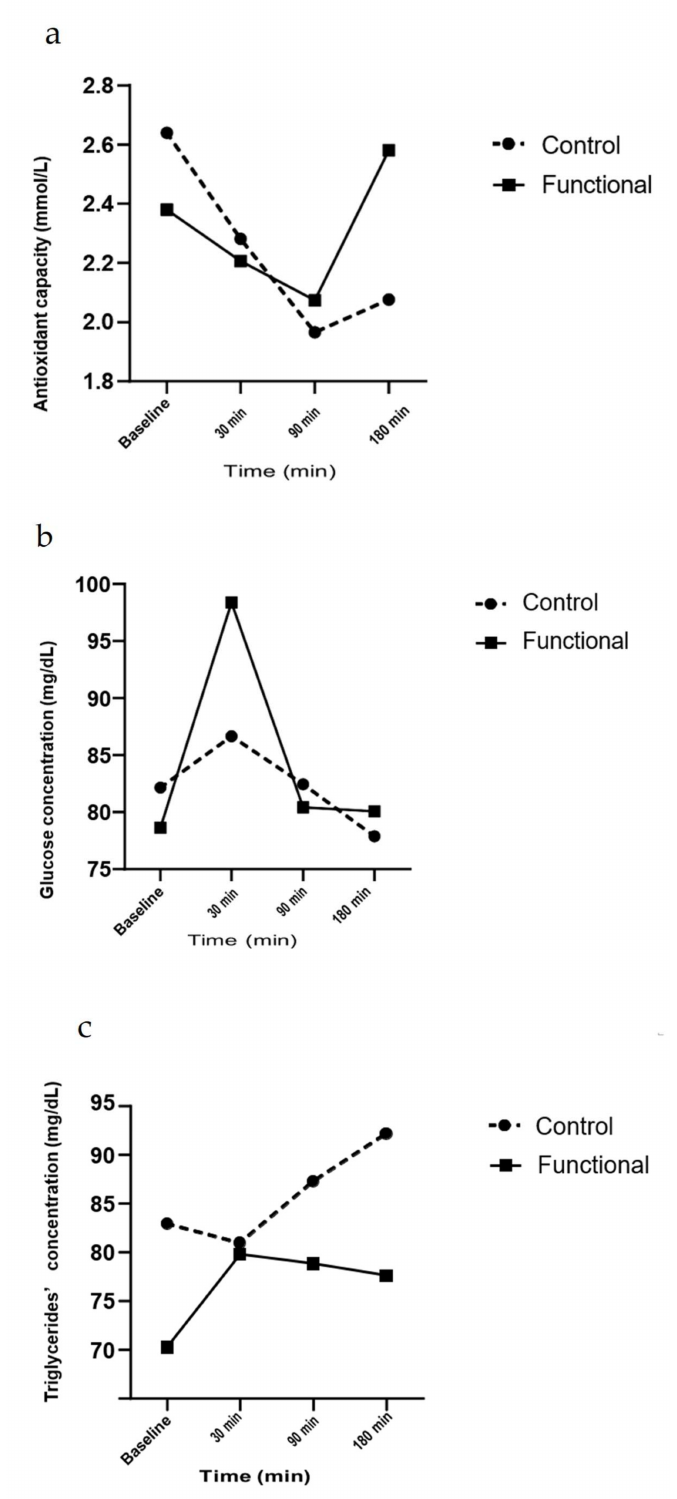
Figure 2. Incremental Area Under Curve (AUC) for antioxidant capacity, glucose and Triglycerides. ( a ) Venous plasma antioxidant capacity presented as Incremental Area Under Curve (AUC) following consumption of the Functional or the Control meal. ( b ) Serum glucose presented as AUC following consumption of the Functional or the Control meal. ( c ) Serum triglycerides presented as AUC, following consumption of the Functional or the Control meal. Values are presented as means ± SD, n =